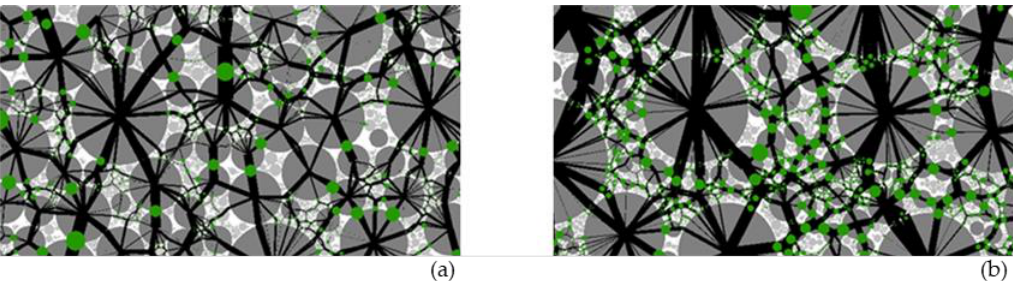
Figure 4. Distribution of contact points and contact force with different segregation levels: HC ( a ) and HC ( b ).